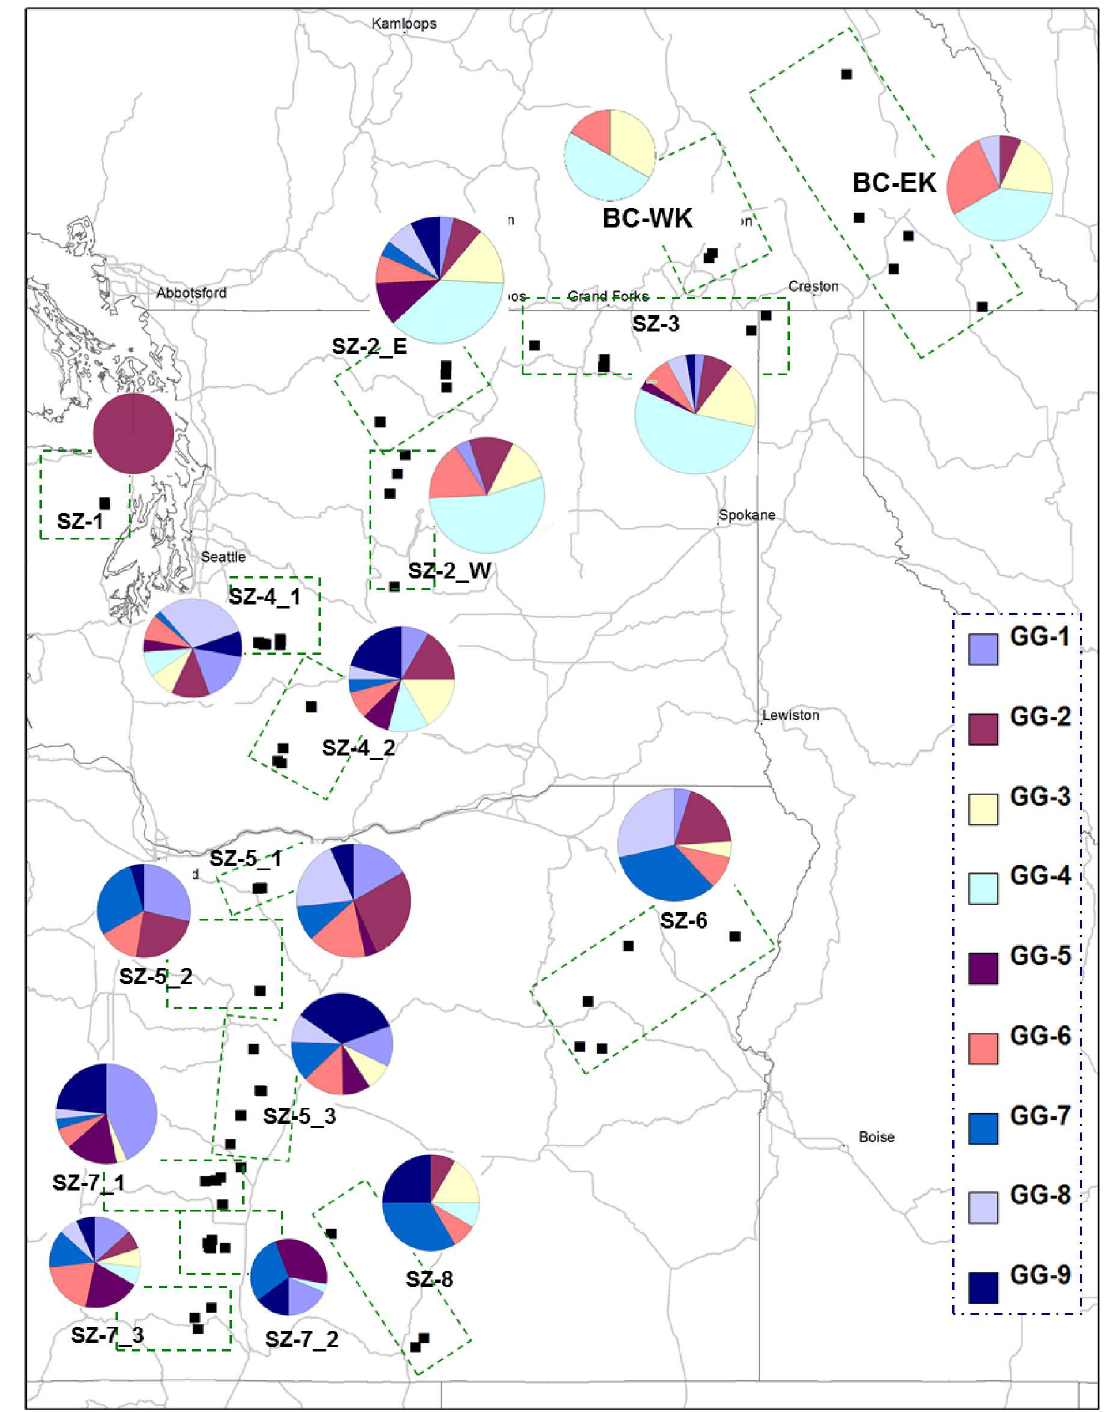
Fig 1. Locations of seed families and geographic distribution of genetic subgroups. A total of 124 seed families were samplesin 16 seed (sub) zones. Each pie chart representsthe proportionof genetic subgroups (GG-1 to GG-9) as identified by STRUCTURE in a given